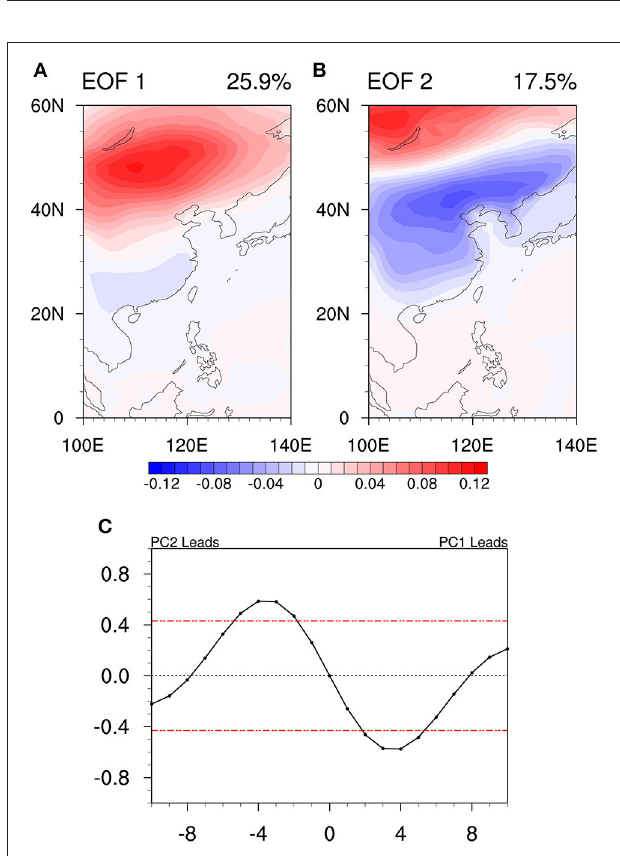
FIGURE 3 | The first EOF mode (A) and the second EOF mode (B) of the 10–30-day filtered air temperature at 2m in boreal summer (unit: K); (C) The lead-lag correlation coefficients between two leading EOF principal components PC1 and PC2. The red dashed line represents a 95% significance